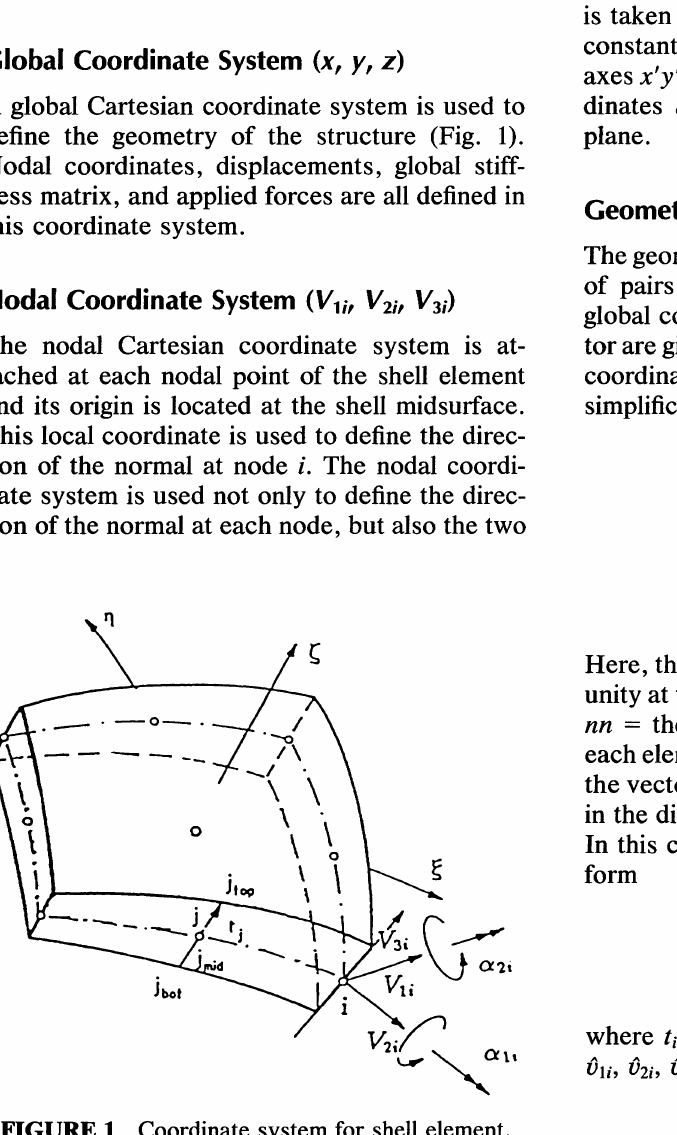
FIGURE 1 Coordinate system for shell